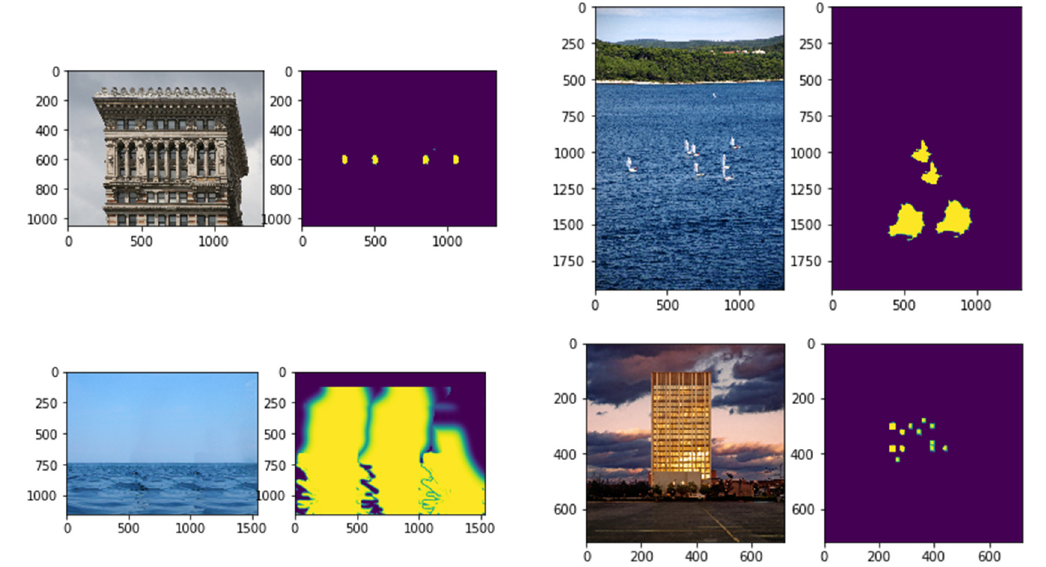
Figure 5. Some examples of multiple copy–move forgeries detection. The first and third columns represent the forged images. The second and fourth columns represent the detection results of the proposed model.